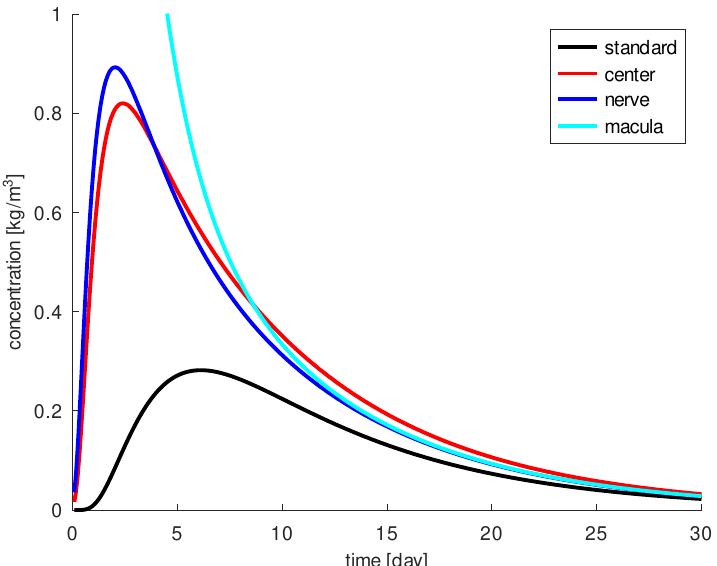
Figure 4. We test four different injection positions. Position 1 (called standard) is the standard position for an injection in the left eye: 3.5 mm from the limbus via the pars plana direction to the center of the posterior pole, needle depth about 5 mm; Position 2 (called center) is 10 mm from the limbus via pars plana direction to the center of the posterior pole, needle depth about 10 mm; Position 3 (called nerve) is 8 mm from the limbus via pars plana direction laterally to the posterior pole and the needle penetrates 7–8 mm; Position 4 (called macula) is chosen 10 mm from the limbus via the pars plana direction to the center of the posterior pole with an 18 mm needle (injection site near the macula) penetrating in the direction of the optic